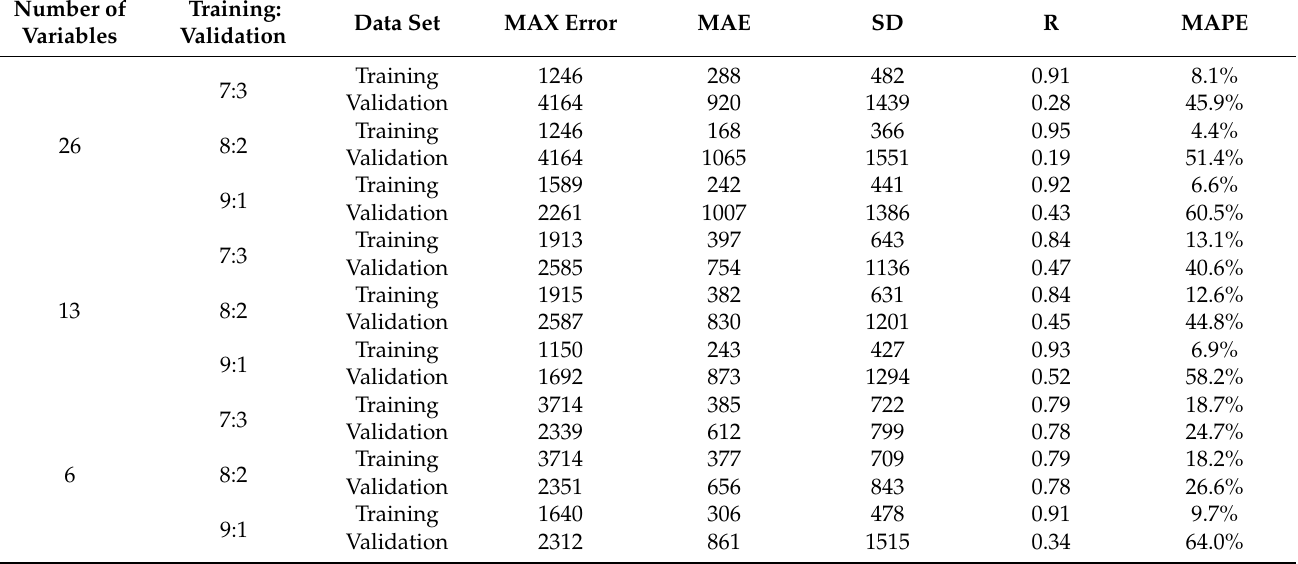
Table A16. Analysis of the results of the ECHAID model for natural gas